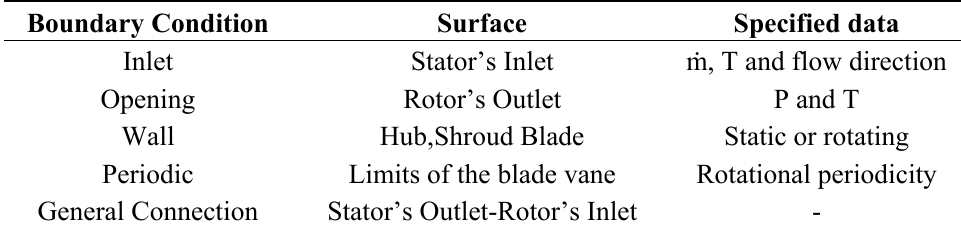
Table 7. Assigned boundary conditions.